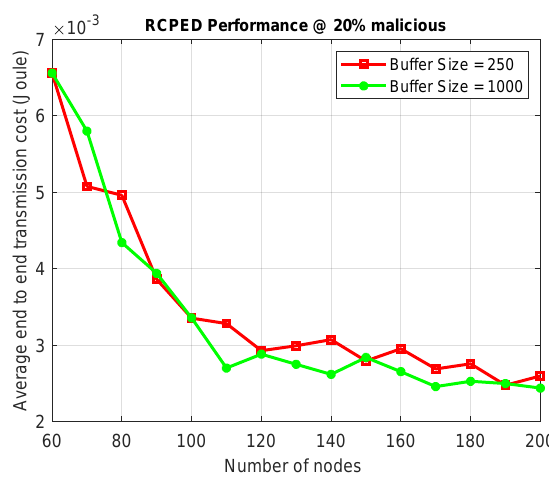
Figure 9. RCPED performance with different buffer size.